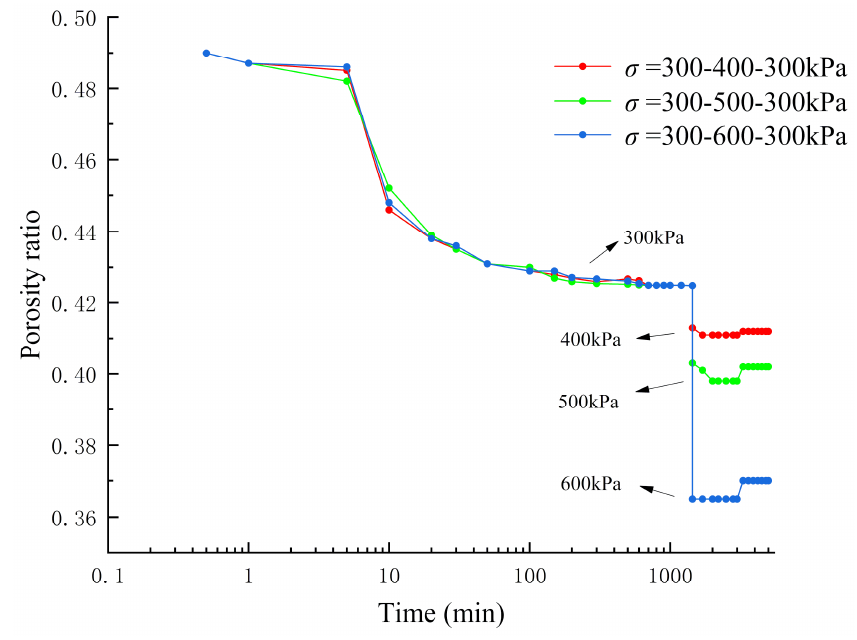
Figure 6. The porosity ratio–time curve under different loading paths.